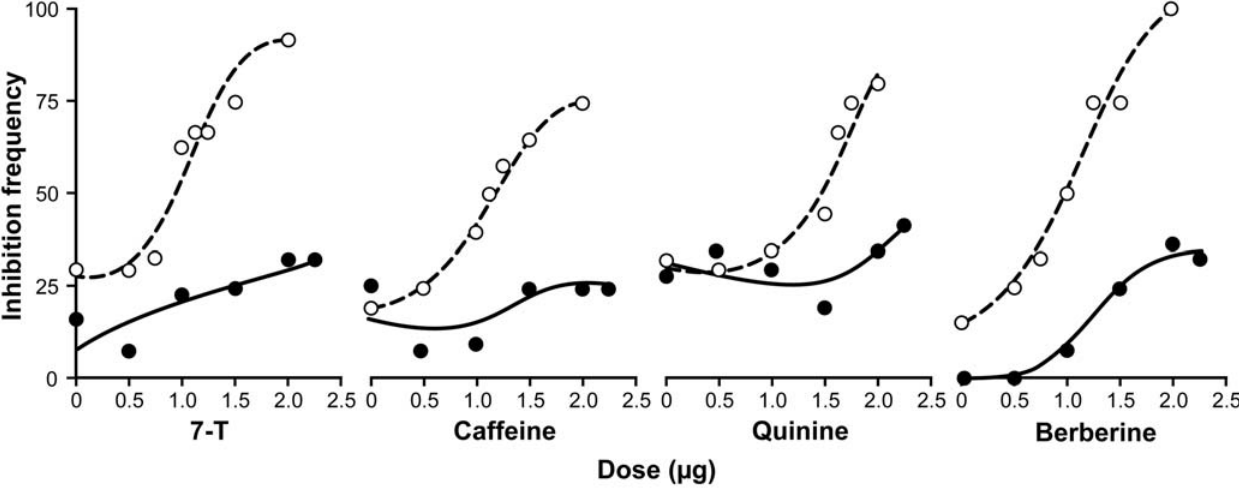
Figure 5. 7-T and of bitter molecules dose-dependently inhibit male courtship. The intensity of courtship (CI) was measured in tester WT males (empty circles) and in Gr66a-Gal4 /WT males (filled circles) paired with decapitated desat1 target males covered either with pure 7-T or with one of the three bitter molecules—caffeine, quinine or berberine—as indicated below the curves. Each chemical to be tested was diluted in the appropriate solvent at a concentration adjusted to standardize the volume of solvent deposited on each object fly (see Material and methods). The solvents used here had no effect on male CI. The frequency of inhibition corresponds to the number of males with CI , 44.1 (observed in the control situation between two WT males). For example, 50% inhibition indicates that 50% of the tester males showed a CI , 44.1. n=20–30.